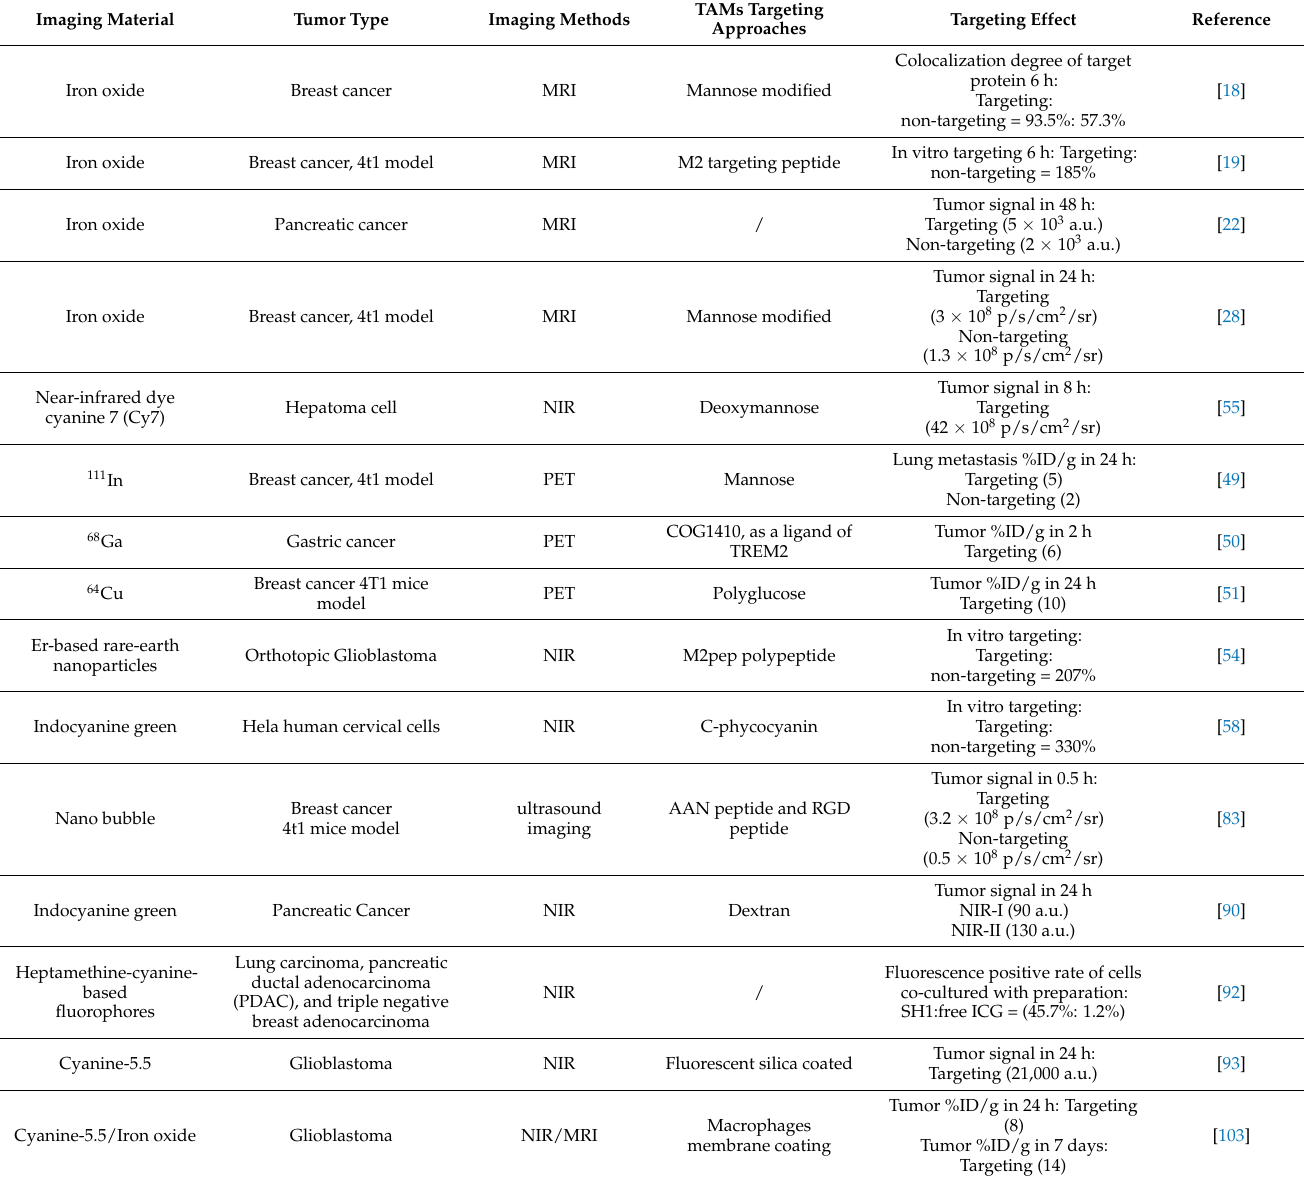
Table 2. Targeting efficiency of TAM-imaging